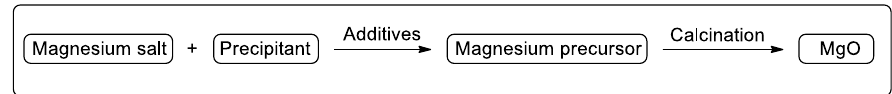
Figure 6. General method for preparation of magnesium oxide.